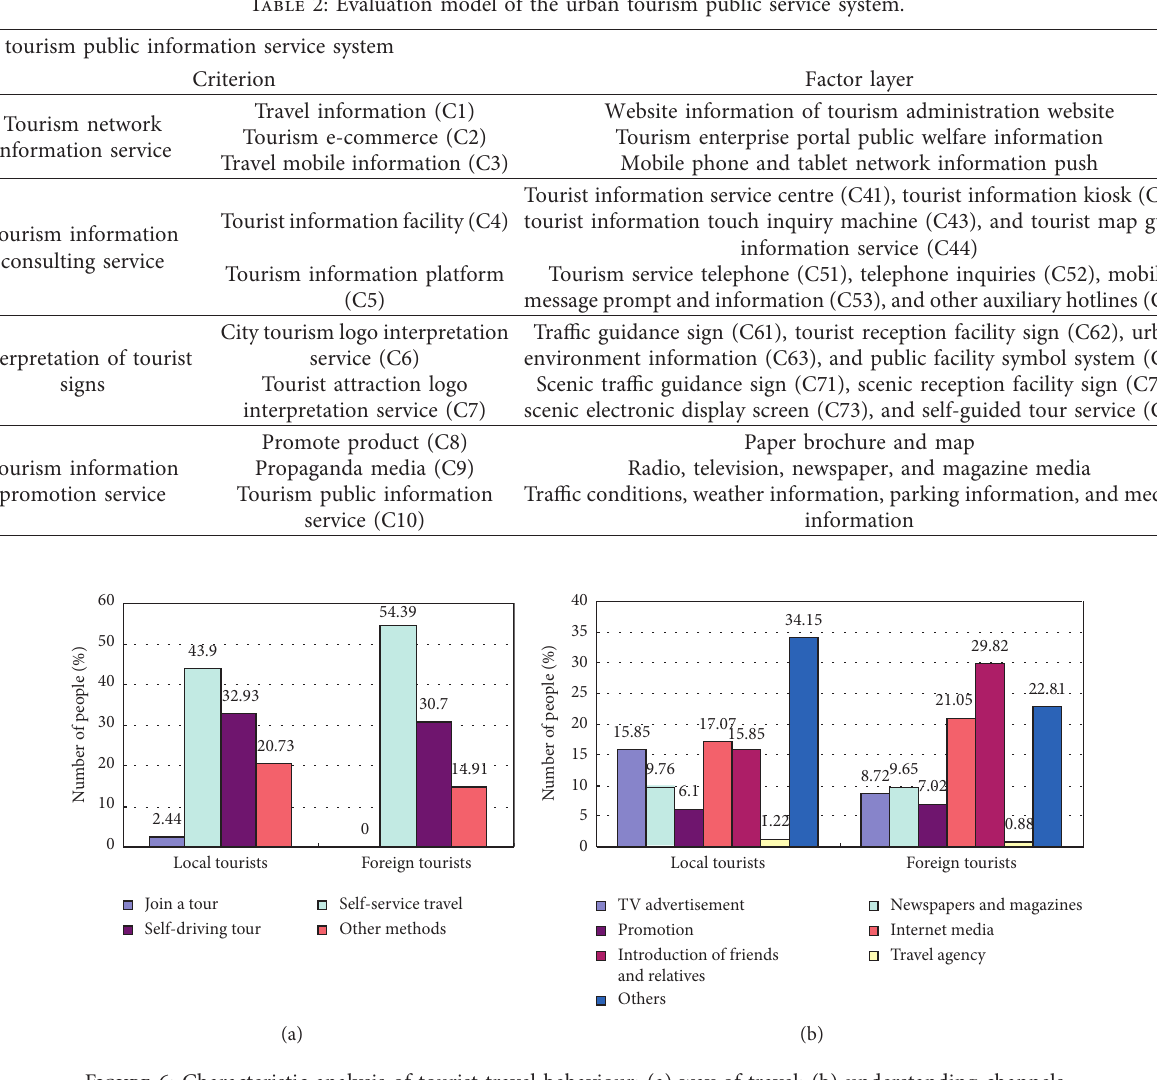
Table 2: Evaluation model of the urban tourism public service